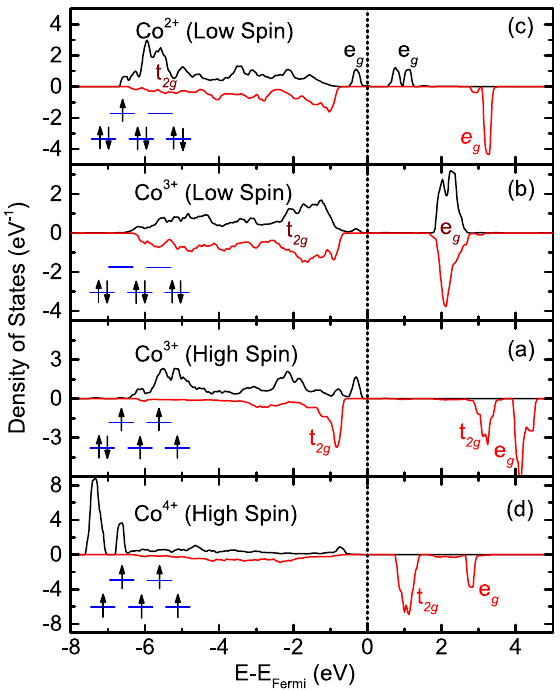
Fig. 4 The partial density of states of the Co 3d states of different oxidation states and spin states in the excited state presented in Fig. 3. Spin-up and spin-down channels are represented by black and red lines, respectively. The electronic configurations of various Co ions in the supercell are schematically shown in the insets at the bottom left corner